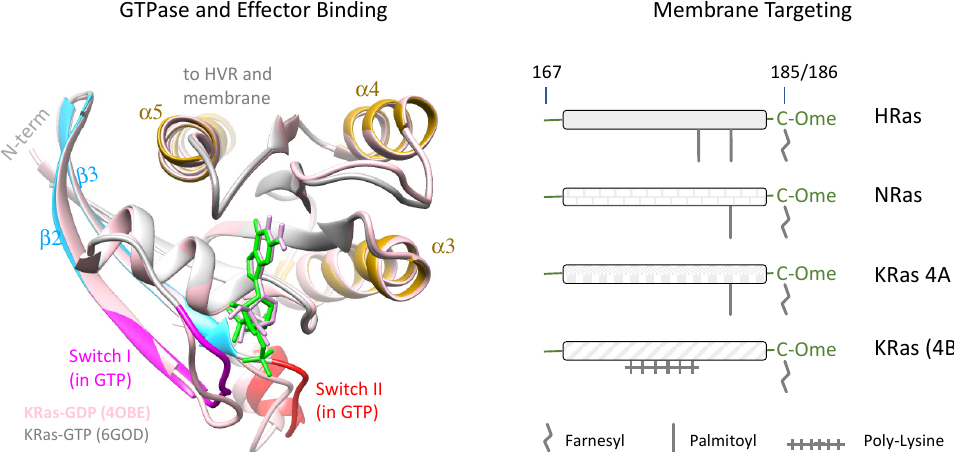
Figure 1. Ras domain structure. Left panel shows a ribbon representation of the heart-shaped Ras G-domain using overlaid KRas-GTP (Protein Data Bank (PDB) 6GOD; GTP shown in green) and KRas-GDP (PDB 4OBE; light pink; GDP in plum) structures as models. Several key elements most relevant to this review, including Switch I (residues 30–40, magenta), Switch II (residues 60–70, red), β -sheets 2 ( β 2, residues 37–46, sky blue), β 3 (residues 49–58, sky blue), and α helices 3 ( α 3, residues 87–103, bronze), α 4 (residues 127–137, bronze), and α 5 (residues 152–164, bronze) are highlighted in the KRas-GTP model. Right panel depicts the hypervariable regions (HVRs) of the four major Ras isoforms, namely HRas, NRas, KRas (4A) and KRas (4B) along with the membrane targeting signals (farnesylation, palmitoylation, and the poly-lysine stretch). Figure adapted from ref